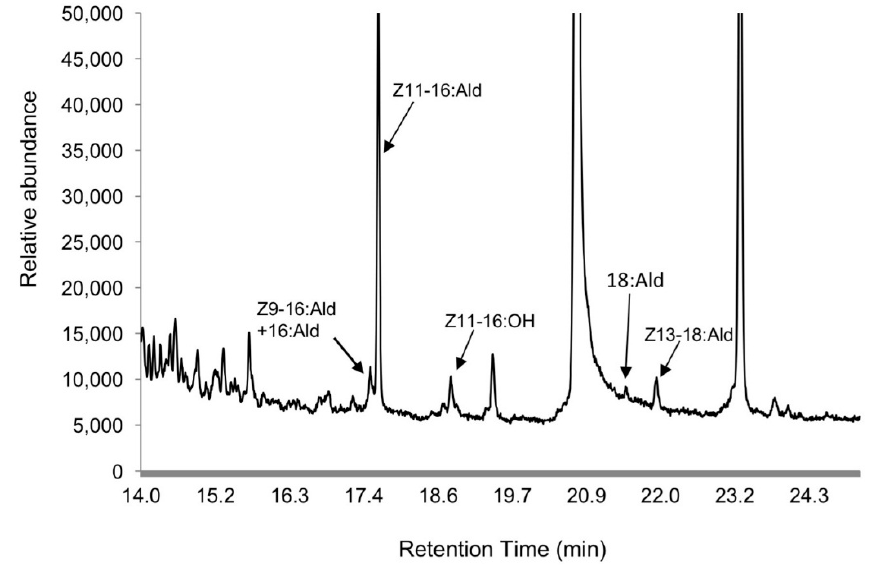
Figure 1. Gas Chromatography coupled with Mass Spectrometry (GC-MS) analysis of crude pheromone extracts from female Chilo suppressalis moths.